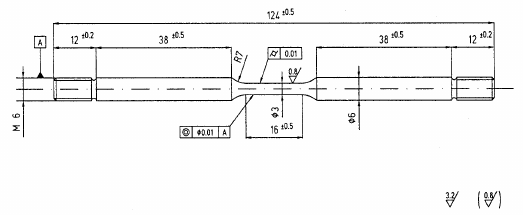
Figure 3. SSR tests specimens.